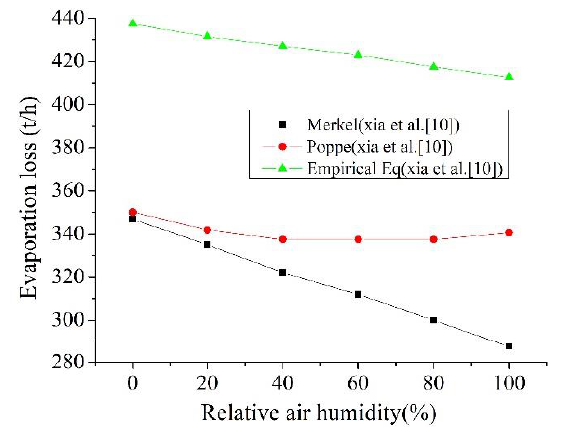
Energies 2020 , 13 , x FOR PEER REVIEW Figure 8. Evaporation loss at vary relative air humidity. Figure 8. Evaporation loss at vary relative air humidity.